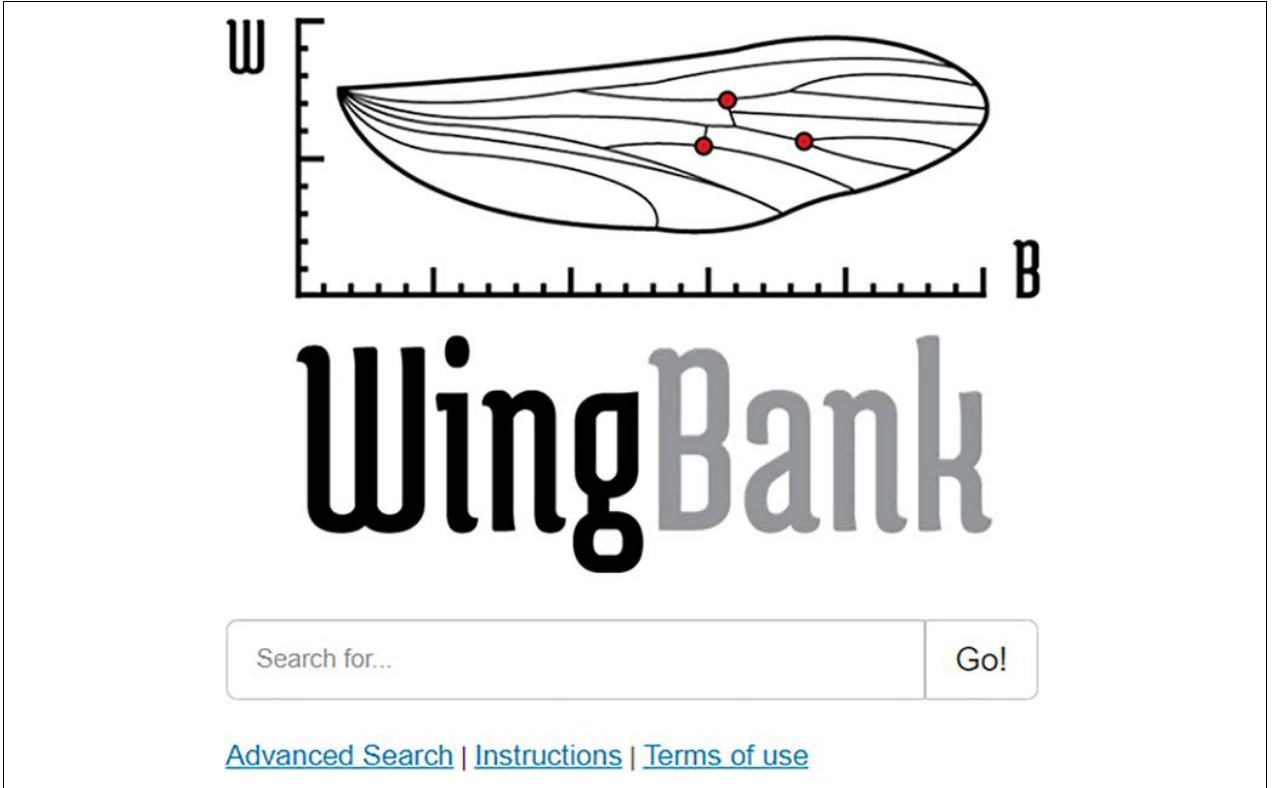
FIGURE 5 | Layout interface of home page and basic search of WingBank